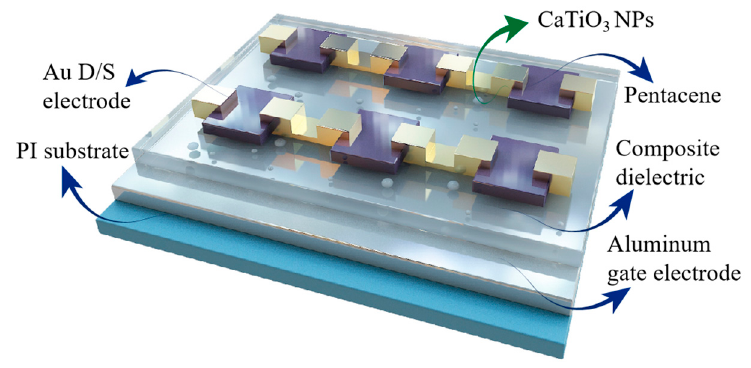
Figure 1. Schematic structures of fabricated organic field-effect transistor (OFET)